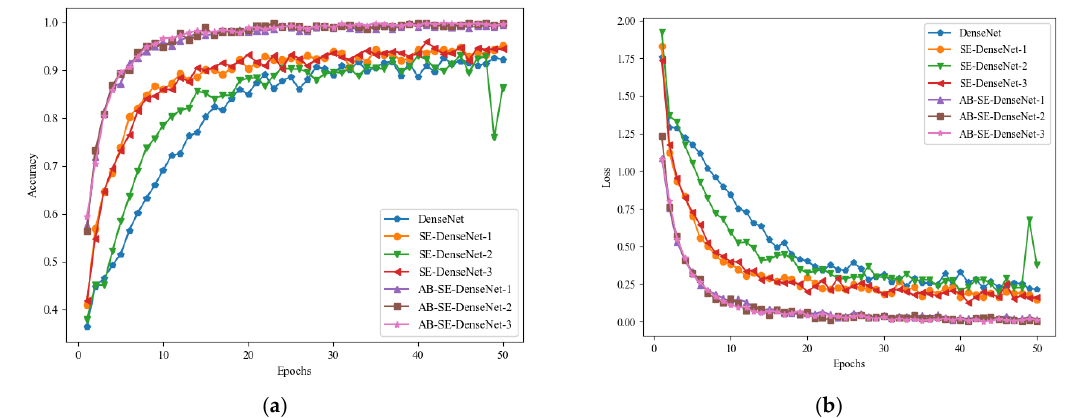
Figure 8. ( a ) Model training accuracy; ( b ) Model training